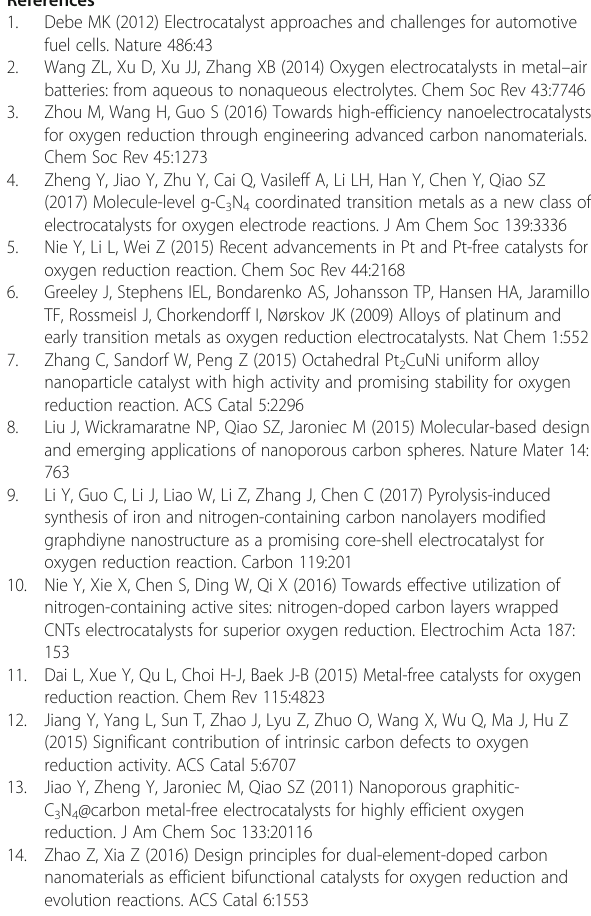
Additional file 1: Figure S1. The BJH pore-size distribution of Me-CFZ- 900. Figure S2. XPS survey data of CF-900, CFZ-900, and Me-CFZ-900. Figure S3. C1s XPS spectra of CF-900 and CFZ-900. Figure S4. (a) LSV curves for ORR of Me-CFZ-900 and 20wt% Pt/C catalyst; (b) The electron transfer number and H 2 O 2 yield of Me-CFZ-900 and 20wt% Pt/C catalyst. Figure S5. LSV curves for ORR of 20wt% Pt/C catalyst before and after AAT in O2-saturated 0.1M KOH solution. Table S1. The contents of nitro- gen, carbon, and oxygen inside the prepared catalysts detected by elem- ental analysis. Table S2. The ORR catalytic activity data for Me-CFZ-900, other carbon or biowaste-derived catalysts reported in the literature. (DOCX 301